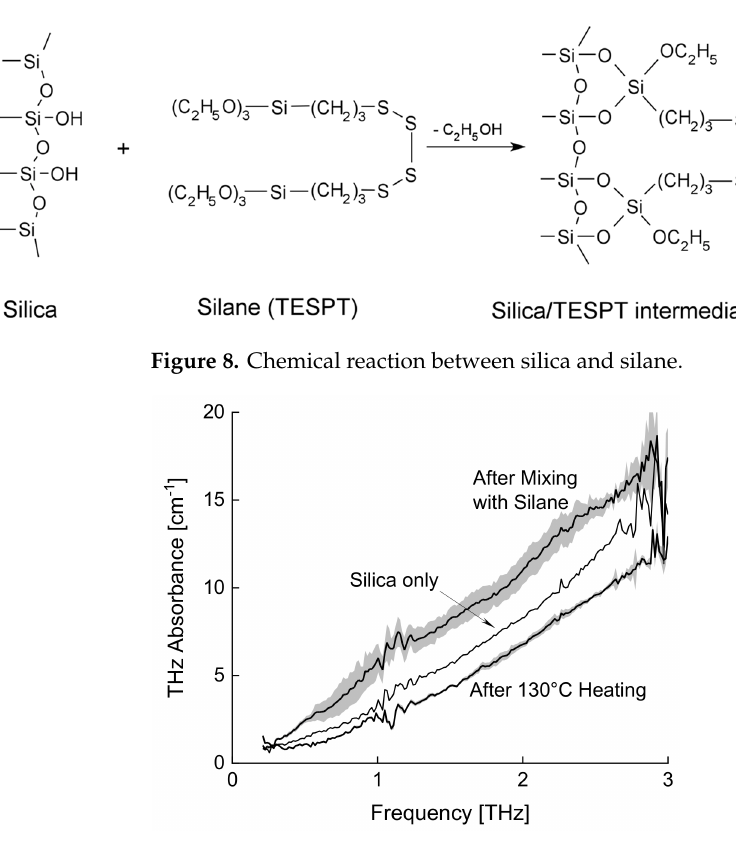
Figure 9. Change of the THz absorbance spectrum by silica-silane chemical reaction. Gray-colored zones mean standard